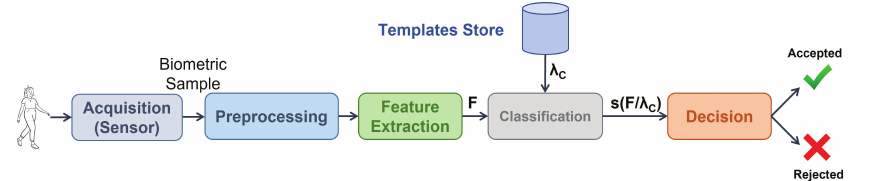
Figure 1. Main modules in a biometric system, where F stands for the feature vector (mathematical representation of the biometric sample), λ C stands for the template (model) of the user C to be authenticated (Claimant), and s ( F / λ C ) is the score (classifier output), which is a measure of the degree of belonging of the biometric sample to the user.